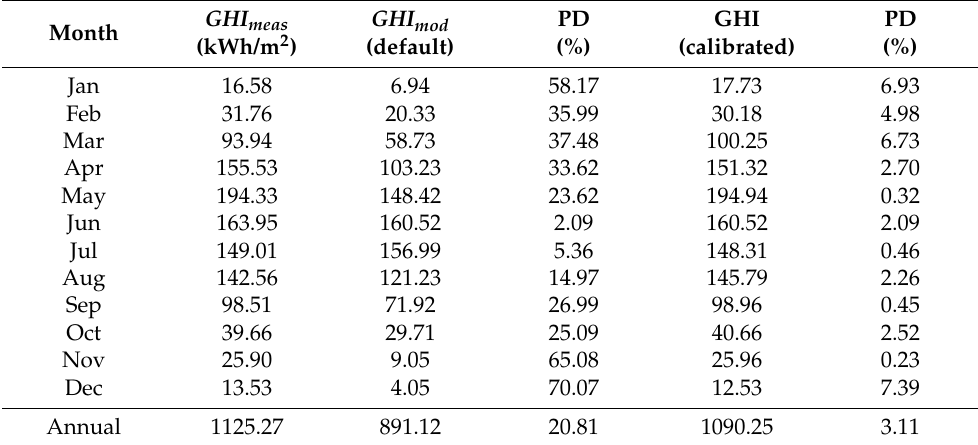
Table 1. Global horizontal irradiation (GHI) from de Bilt from measured ( GHI meas ), results from solar radiation default model D3T5 ( GHI mod ) for the year 2020 and the corresponding percentage differences (PD).